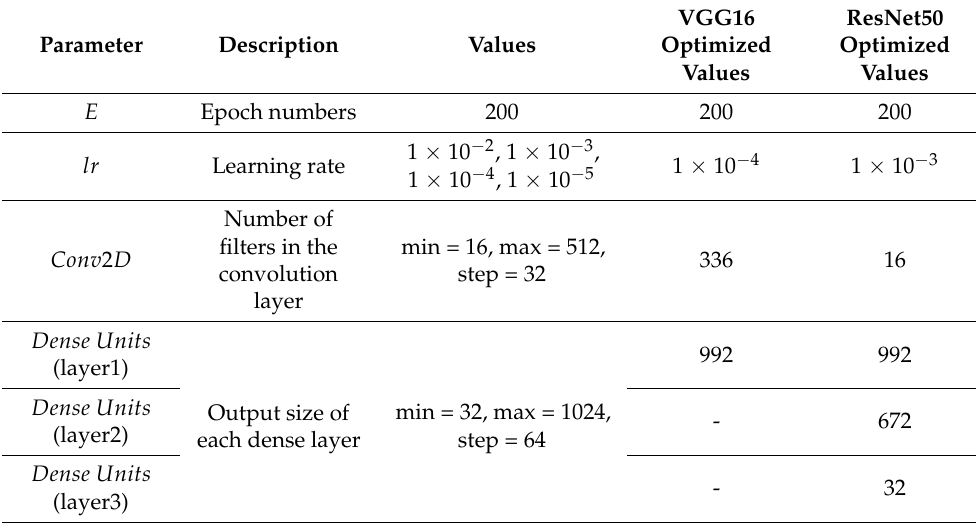
Table 7. Parameters choice list for the optimization of two methods of transfer learning, VGG16 and ResNet50.